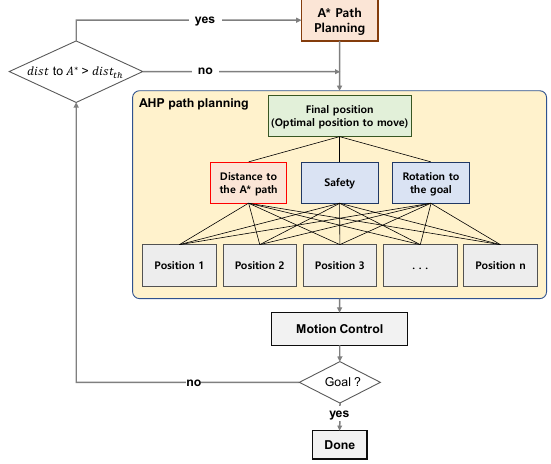
Figure 7. Hybrid path-planning structure.